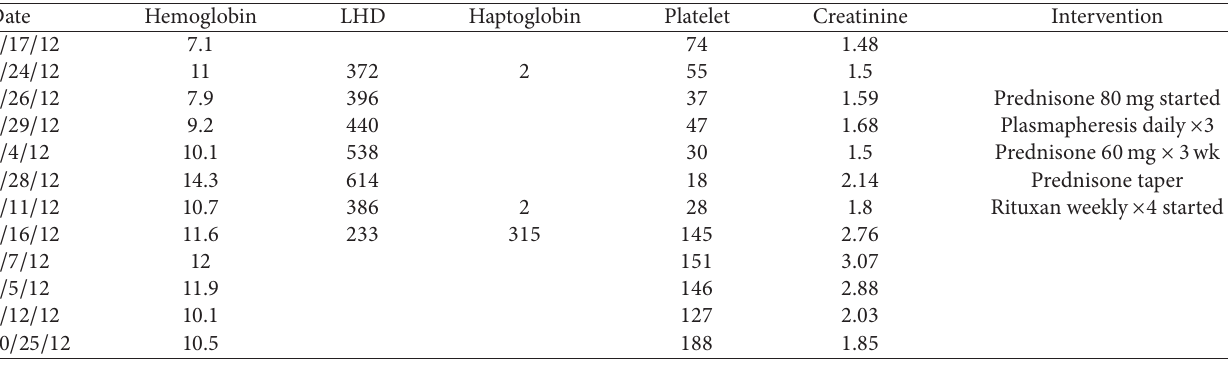
Table 1: Measured lab values in patient’s course.